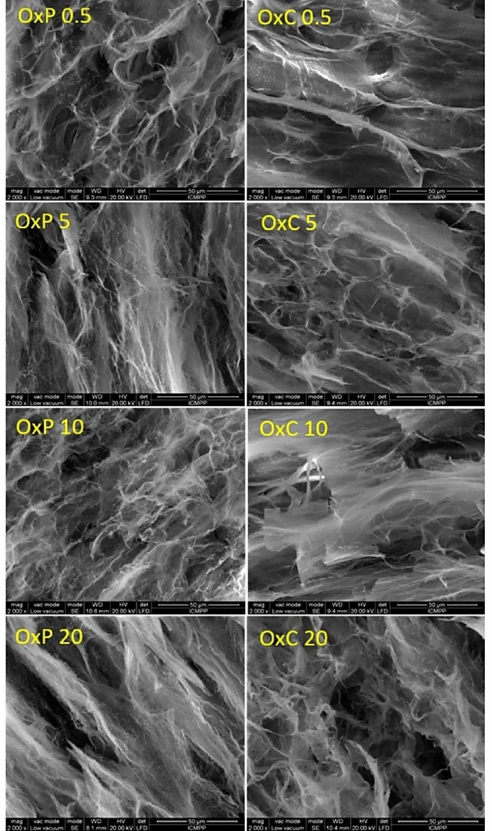
Figure 5. SEM images (2000 × magnification) of PVA scaffolds with oxidized pullulan (0.5% (OxP 0.5), 5% (OxP 5), 10% (OxP 10) and 20% (OxP 20)) and tricarboxy cellulose (0.5% (OxC 0.5), 5% (OxC 5), 10% (OxC 10) and 20% (OxC 20)) respectively